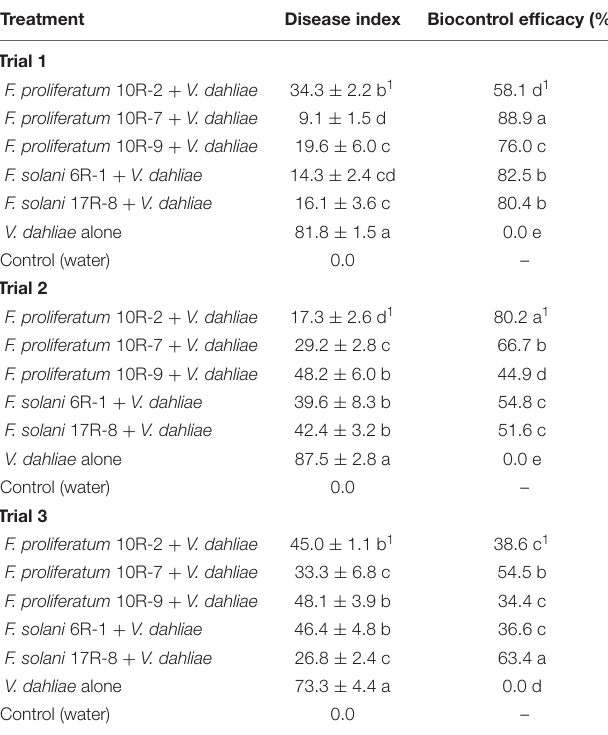
TABLE 2 | Endophytic fungi in cotton tissue in Wuhan of central China. Species Number of fungal isolates